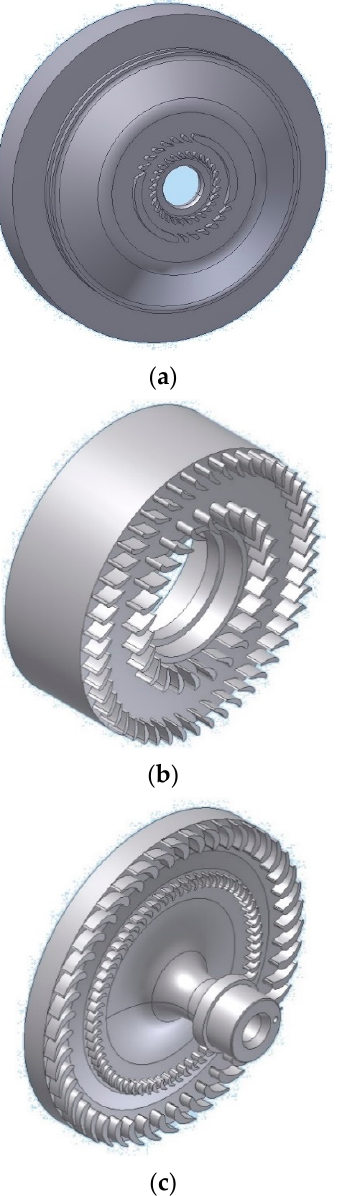
Figure 5. CAD model of a 2.5 kW ORC turbine: ( a ) stator of stage 1 and 2, ( b ) rotor of stage 1 and 2, ( c ) rotor of stage 3 and 4, ( d ) meridional section of the microturbine flow part. Table 4. ORC microturbine operational regimes. Inlet/outlet boundary conditions and isentropic quantities.